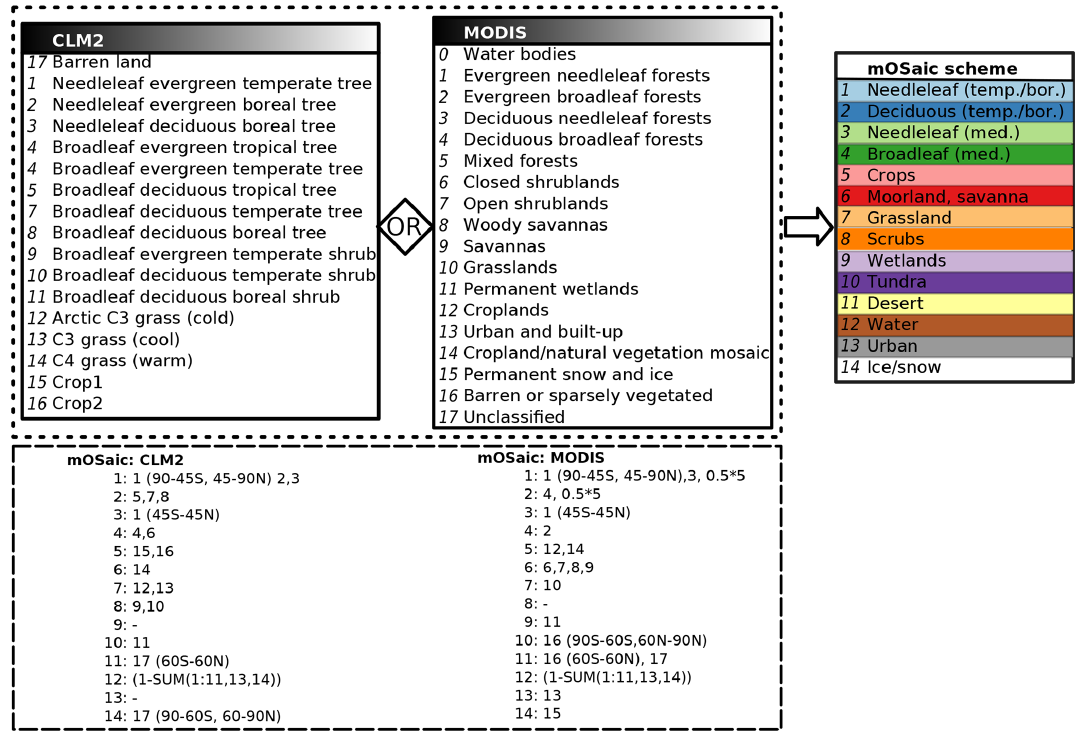
Figure 2. Mapping of land surface categories. Either land surface categories from ISLSCP2 product of MODIS or the Community Land Model (CLM) 2 can be chosen for mapping to the land surface types we use in the mOSaic scheme. Water bodies of MODIS are actually not mapped. For both MODIS and CLM 2 land surface categories, snow and ice cover is estimated from input meteorology, while water is defined as 1 − P k f k . From the MODIS category “barren or sparsely vegetated”, everything poleward from 60 ◦ is defined as tundra, while L everything equatorward is categorized as desert.